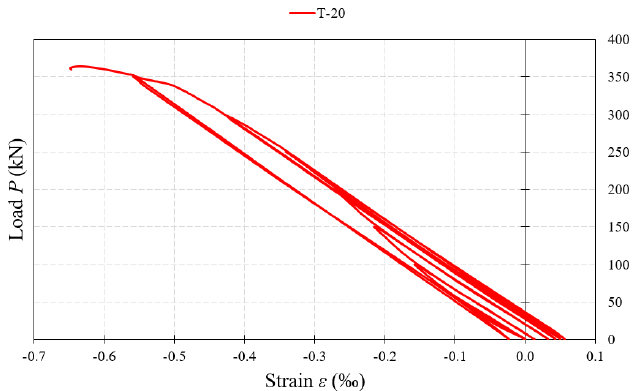
Figure 20. Load–strain relationship at the measurement point (T-20) located on the web surface, at the bottom under the applied force.